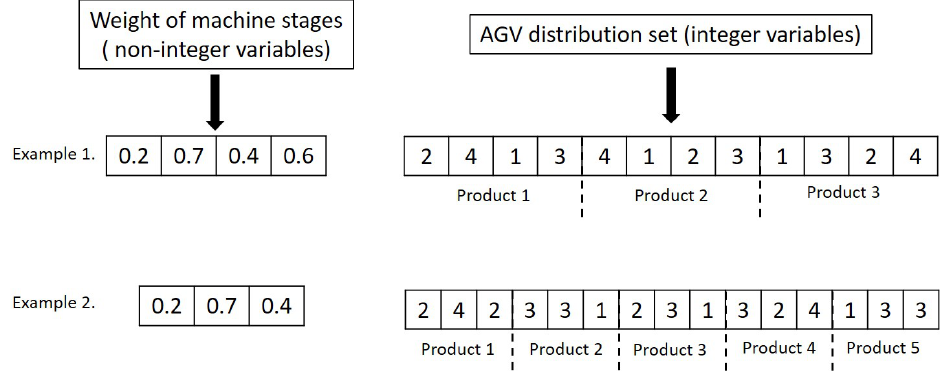
Figure 7. Two examples of the population